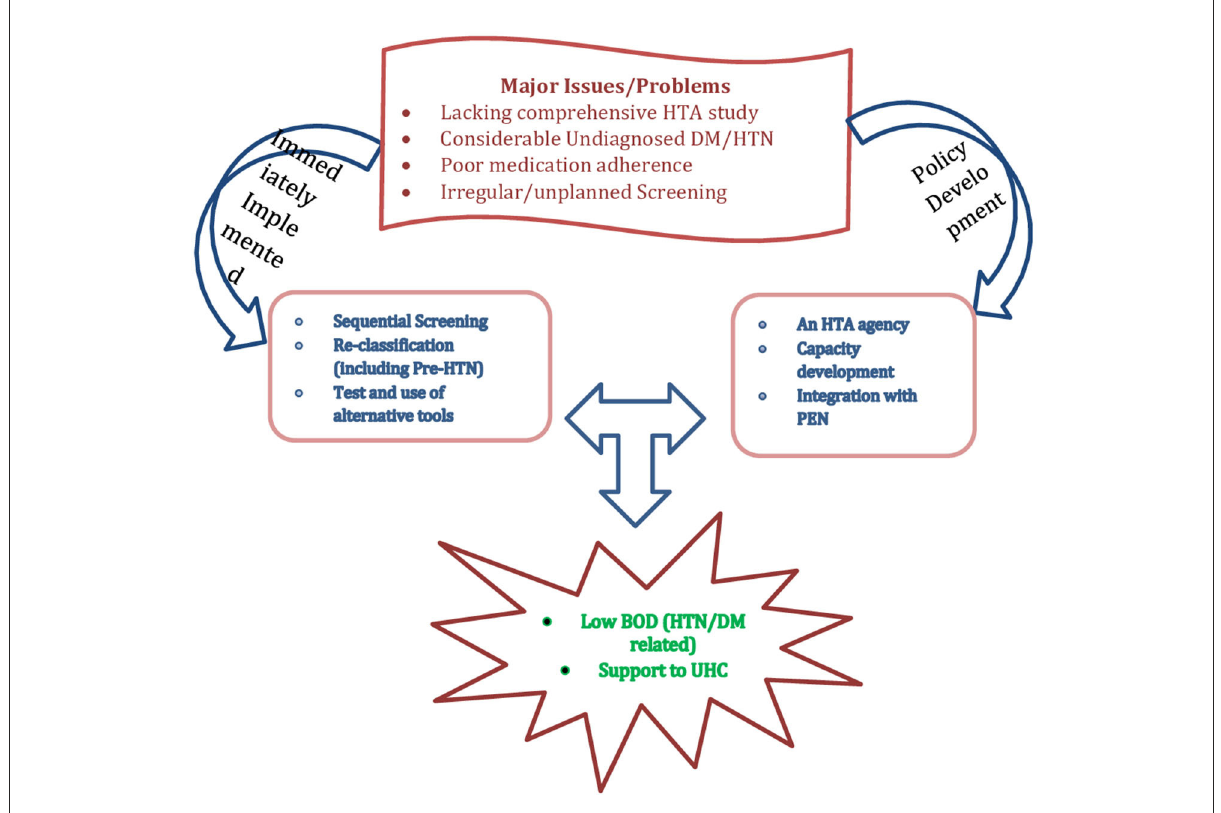
FIGURE2 Summary of